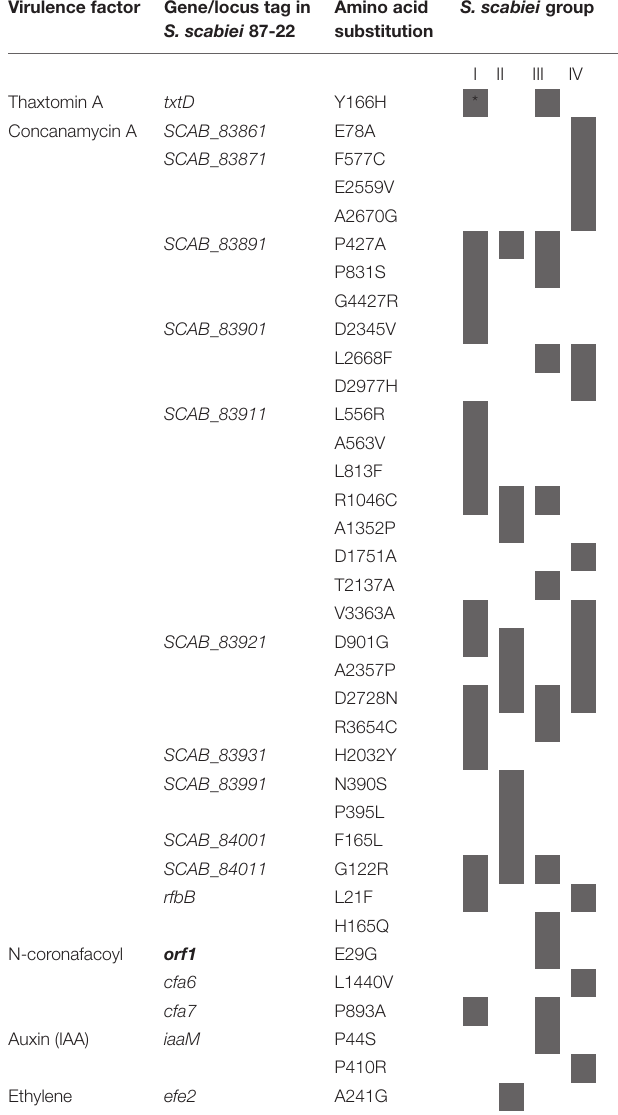
TABLE 3 | Protein mutations encoded by genes involved in the production and/or regulation (bold) of pathogenicity/virulence factors in Streptomyces spp. used in this